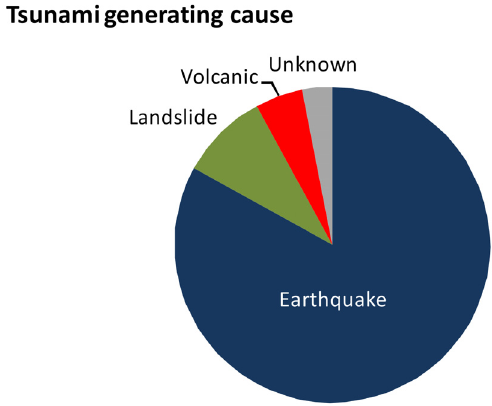
Figure 4. Distribution of the tsunamis in the EMTC by generat- ing